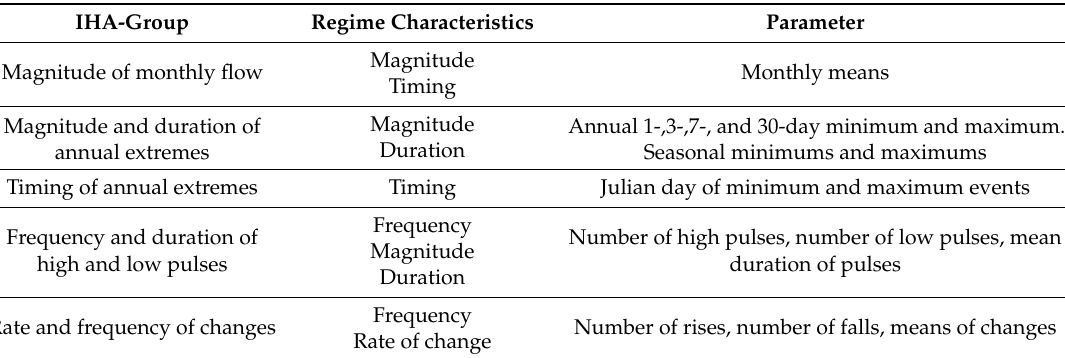
Table 1. The index of hydrological alteration (IHA) parameters used in the Norwegian assessment method (adapted from [7] with permission from John Wiley and